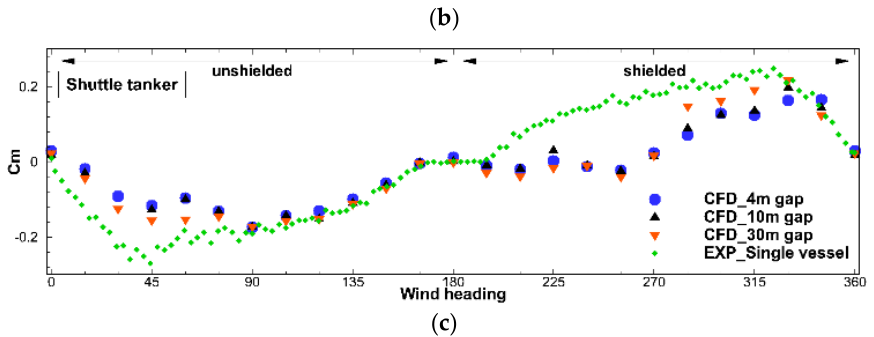
Figure 21. Comparison between single-vessel case and side-by-side case with different gaps for the shuttle tanker. ( a ) 𝐶 𝑥 ; ( b ) 𝐶 𝑦 ; ( c ) 𝐶 𝑚 .